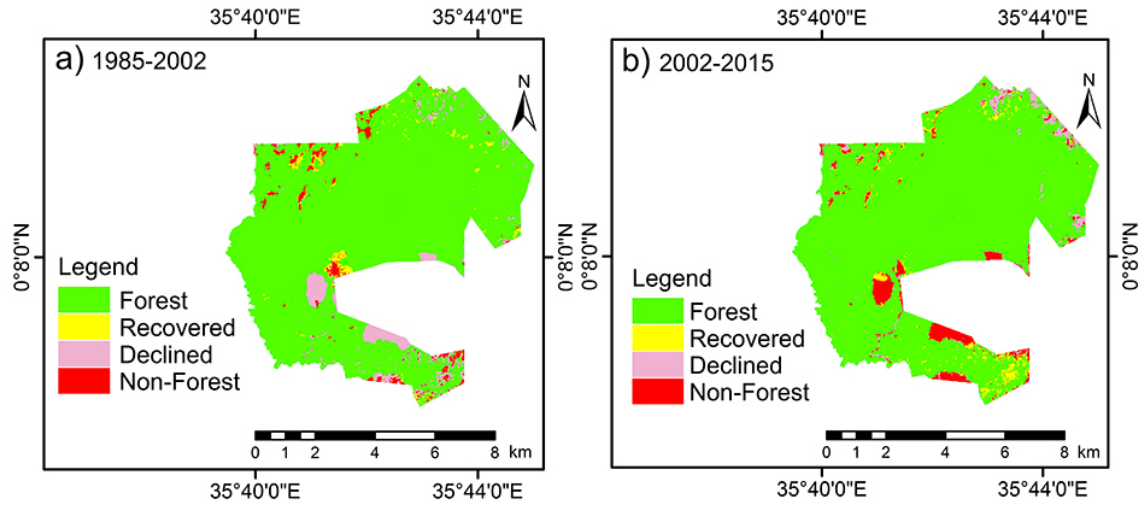
Figure 3. Forest-cover changes in the Chemorgok Forest Block in the ( a ) 1st and ( b ) 2nd periods. Table 8. Forest-cover changes in the Lembus Forest blocks in the 1st and 2nd periods.